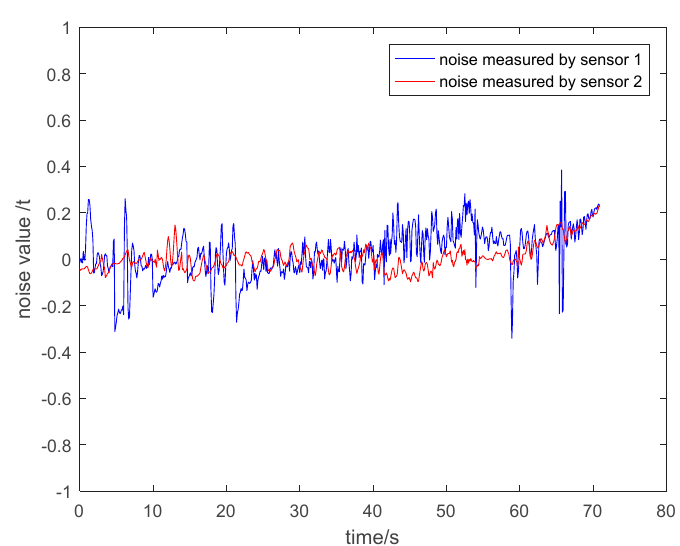
Figure 32. Noise value curves during lifting process of cage with load.